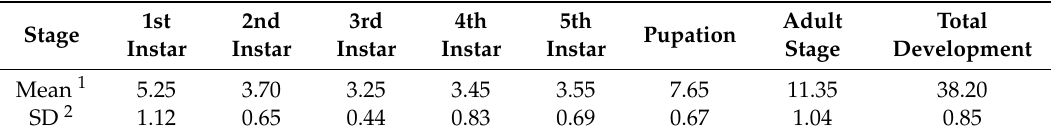
Table 1. Developmental stages of C. lacinia reared on T. diversifolia leaves in the laboratory and their respective